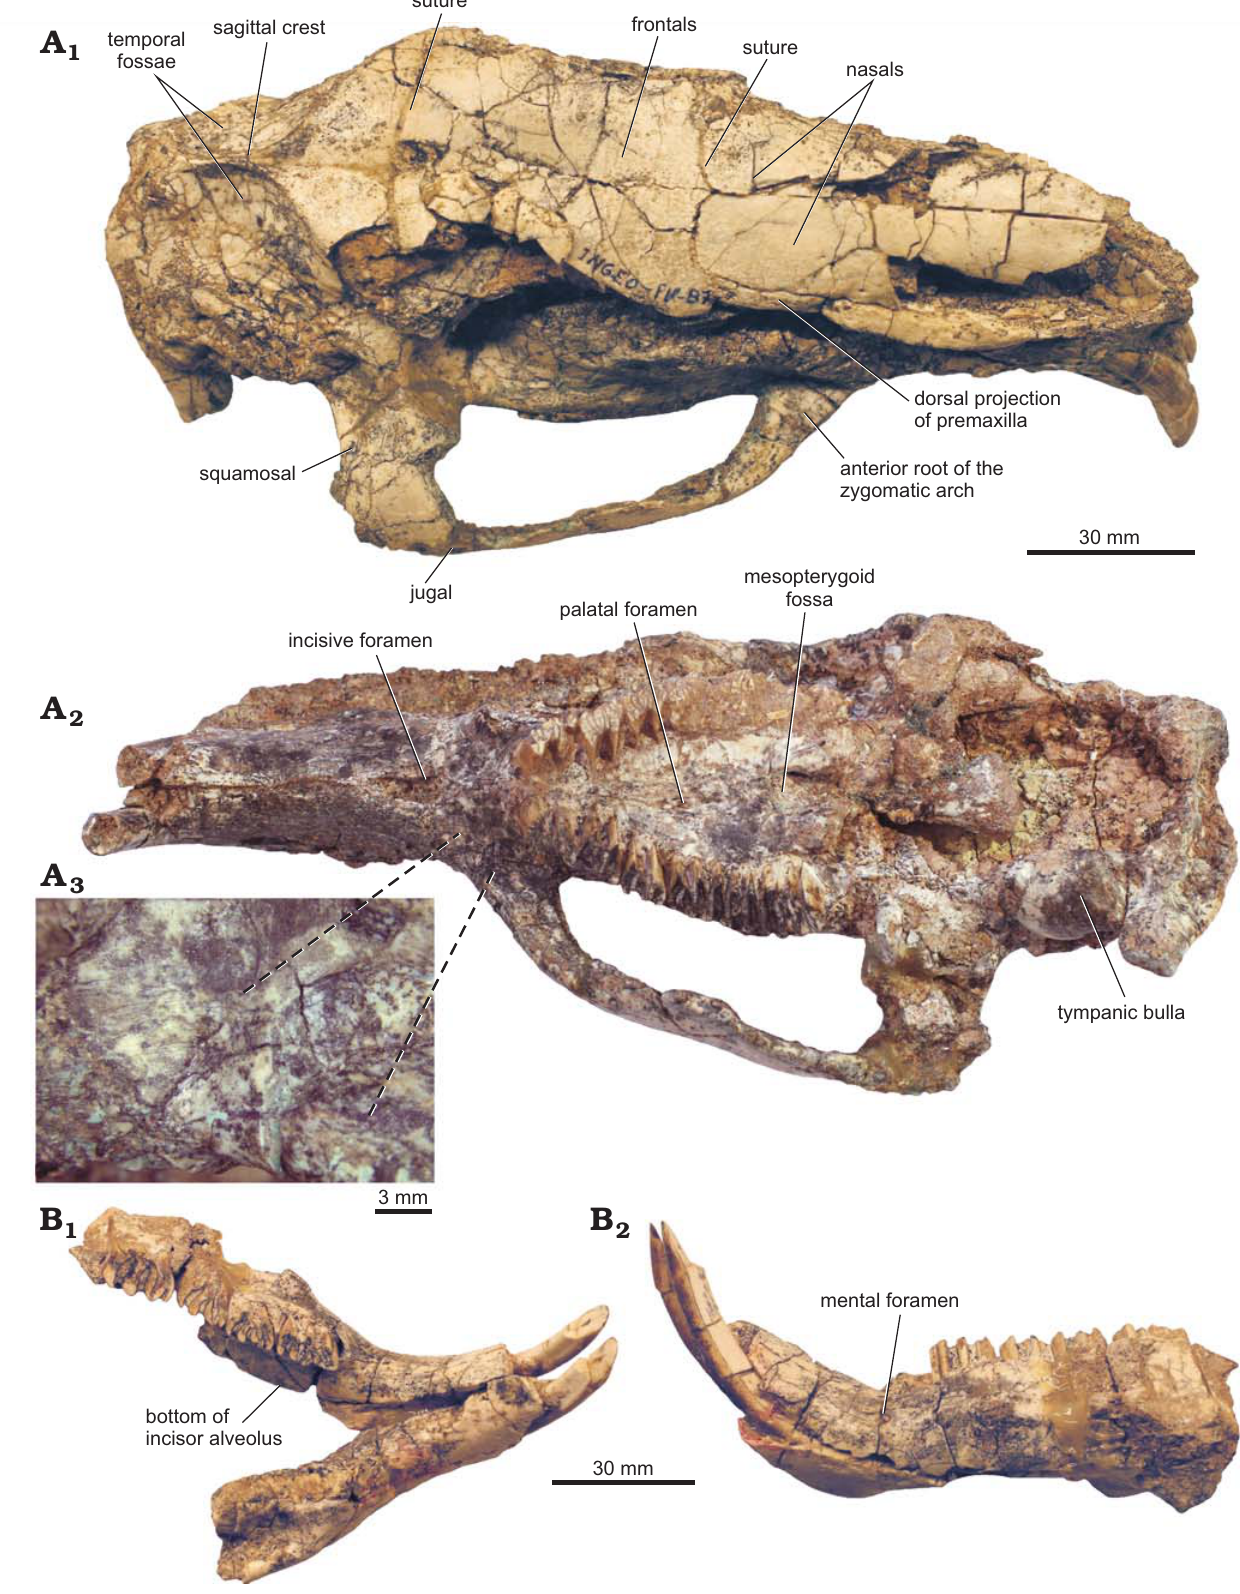
Fig. 3. Holotype (INGEO-PV 87) of the hydrochoerine rodent Cardiatherium calingastaense sp. nov., late Miocene, Puchuzum, San Juan Province, Argentina. A . Skull in dorsal (A 1 ) and ventral (A 2 ) views, and detail of the scars for masseter medialis muscle (A 3 ); correspondence indicated by lines. B . Mandible in occlusal (B 1 ) and left lateral (B 2 )